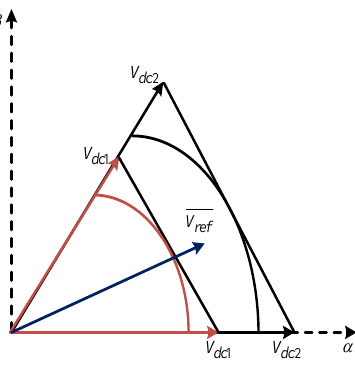
Figure 3. Voltage Space Vector of Proposed modes in sector 1.